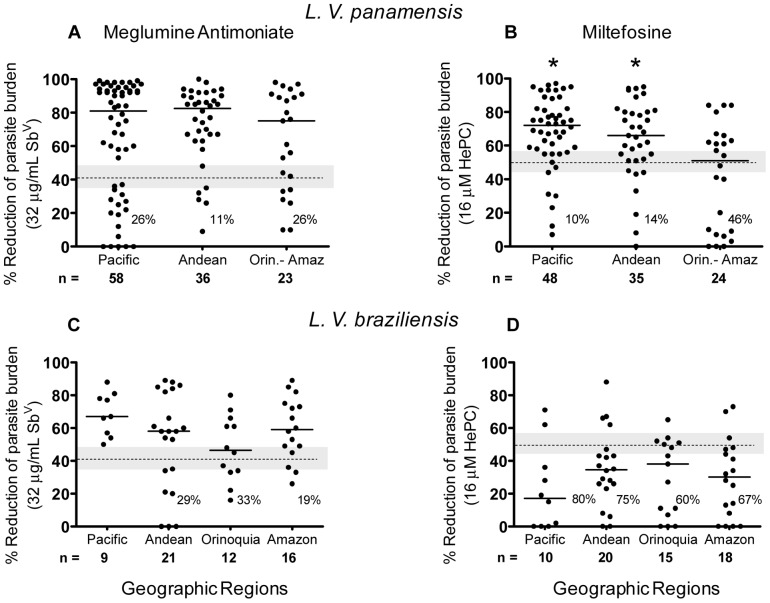
Susceptibility of L. V. panamensis and L. V. braziliensis to meglumine antimoniate and miltefosine by geographic region.Reduction of parasite burden at the discriminatory concentration of SbV (A and C) and HePC (B and D) for L. V. panamensis and L. V. braziliensis strains from Pacific, Andean, Orinoquía and Amazon regions. Because of the lower frequency of L. V. panamensis in regions east of the Andes mountain range, L. V. panamensis strains are combined for Orinoquía and Amazon regions. Qualitative classification of susceptibility is defined by the cutoff thresholds (dotted horizontal line) and indeterminate ranges are illustrated by gray shading. K-W for L. V. panamensis and HePC, P = 0.0012 and Dunn procedure, * P<0.05: Compared with Orinoquía and Amazon regions.